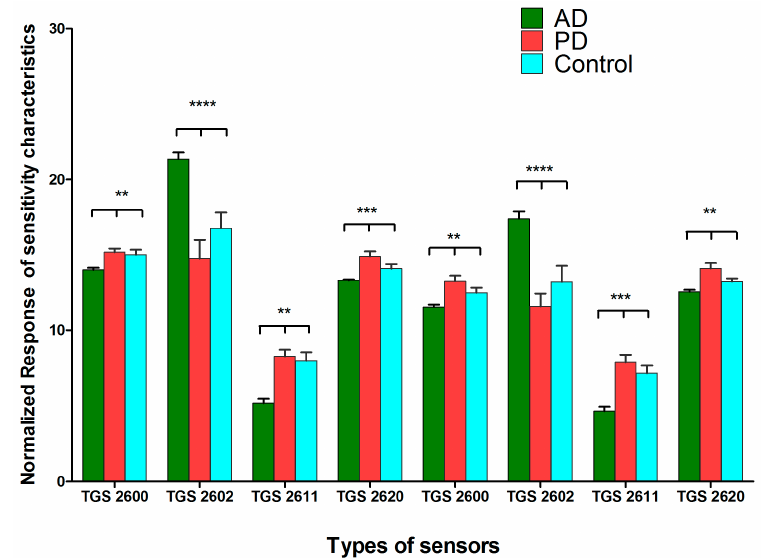
Figure 3. Normalized responses of the sensitivity characteristics for different types of gas sensors (System D). Response sensitivity of exhaled breath samples from patient and control groups to gas sensors. The data are represented as mean ± standard deviation. The p -value was calculated using one-way analysis of variance (ANOVA). Differences were considered significant when the calculated ** p ≤ 0.01, *** p ≤ 0.001, and **** p ≤ 0.0001.